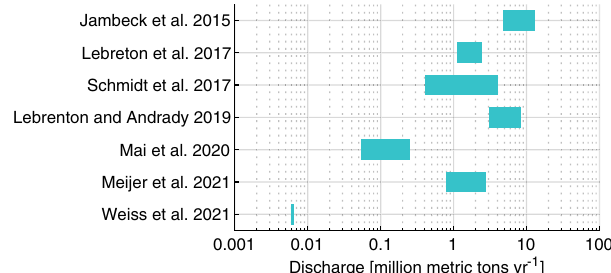
Fig. 1 | Estimated global total plastic waste discharge (million metric tons year − 1 )fromlandtoocean. Notethatthe x -axisislogarithm-based.Jambecketal. 4 consider the emissions from the coastal zones, while Lebreton et al. 5 , Schmidt et al. 83 , Mai et al. 7 , Meijer et al. 8 , and Weiss et al. 9 consider only riverine discharge, and Lebreton and Andrady 84 include both riverine and coastal zone